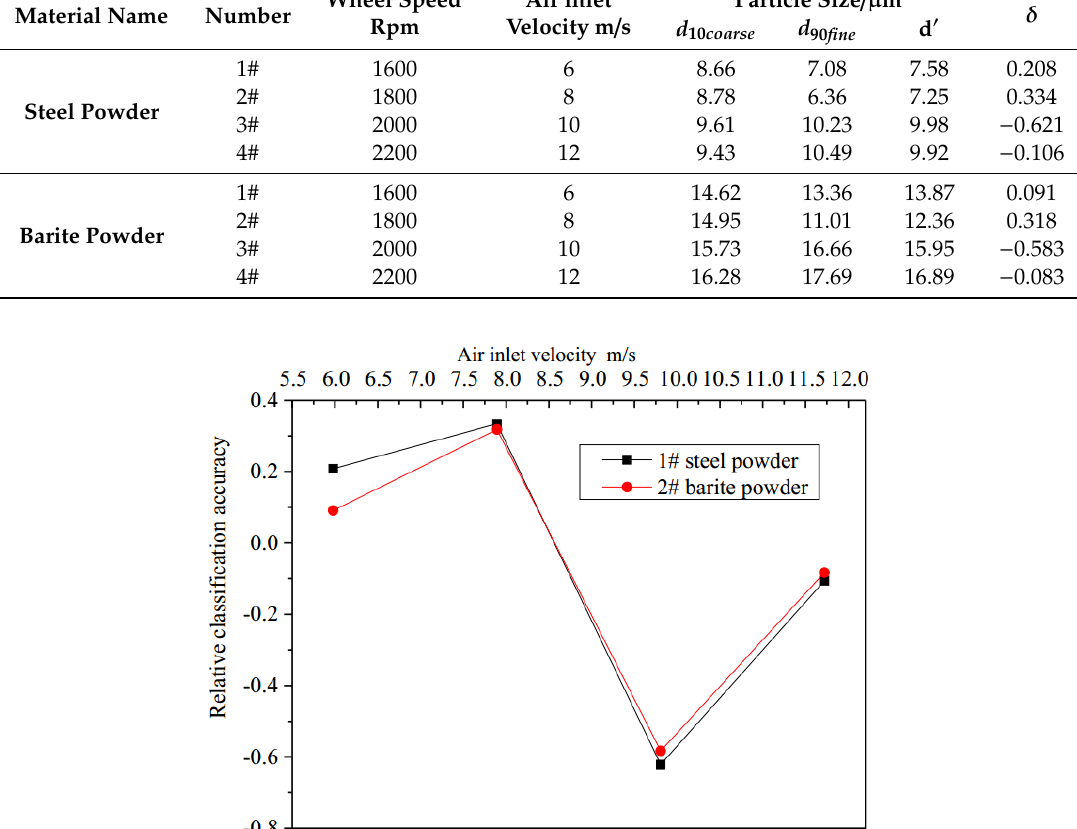
Table 1. Relative classification accuracies under different process parameters.